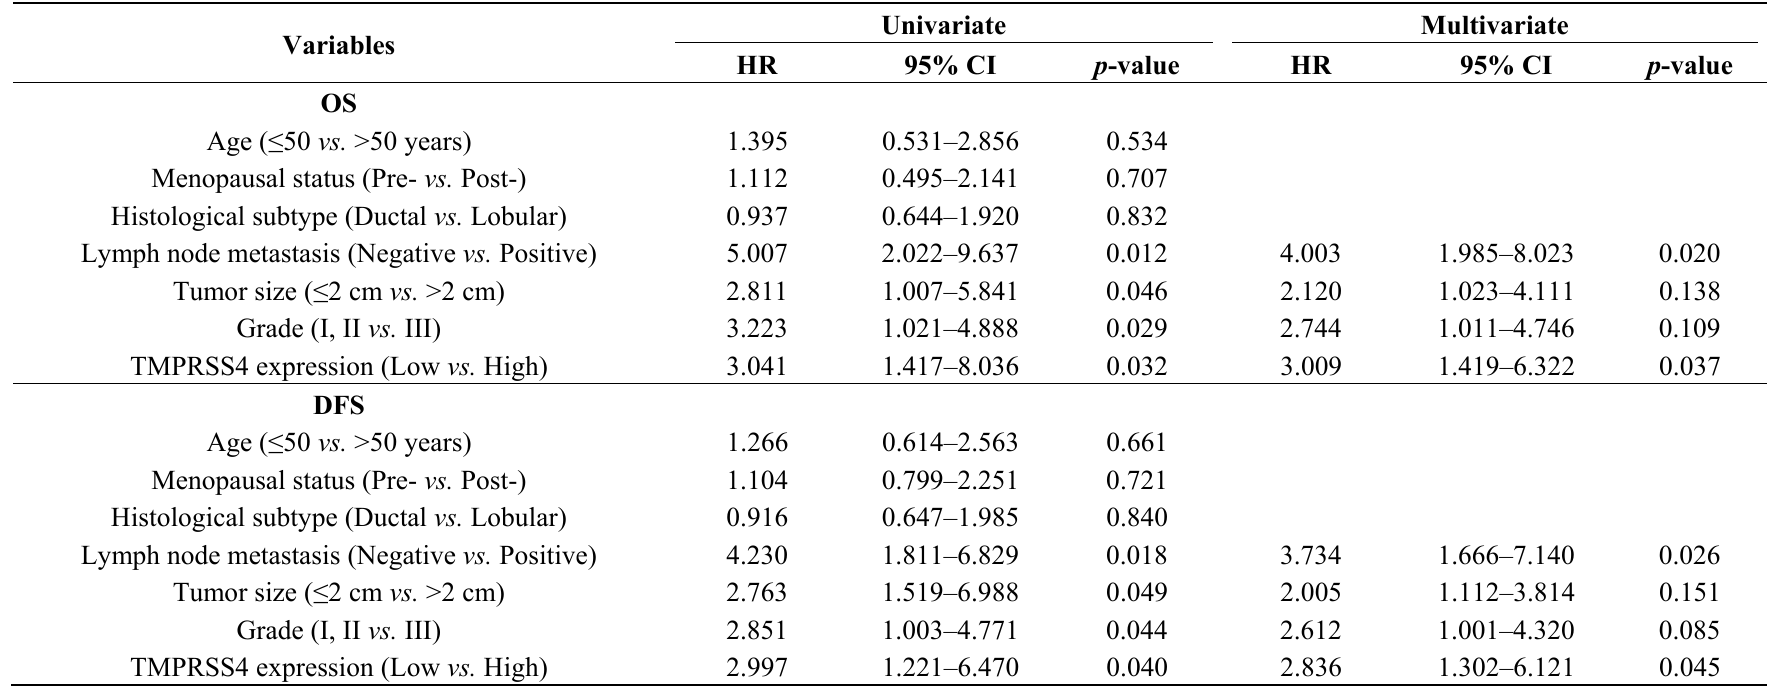
Table 3. Univariate and multivariate Cox Proportional Hazards Model for OS and DFS in TNBC